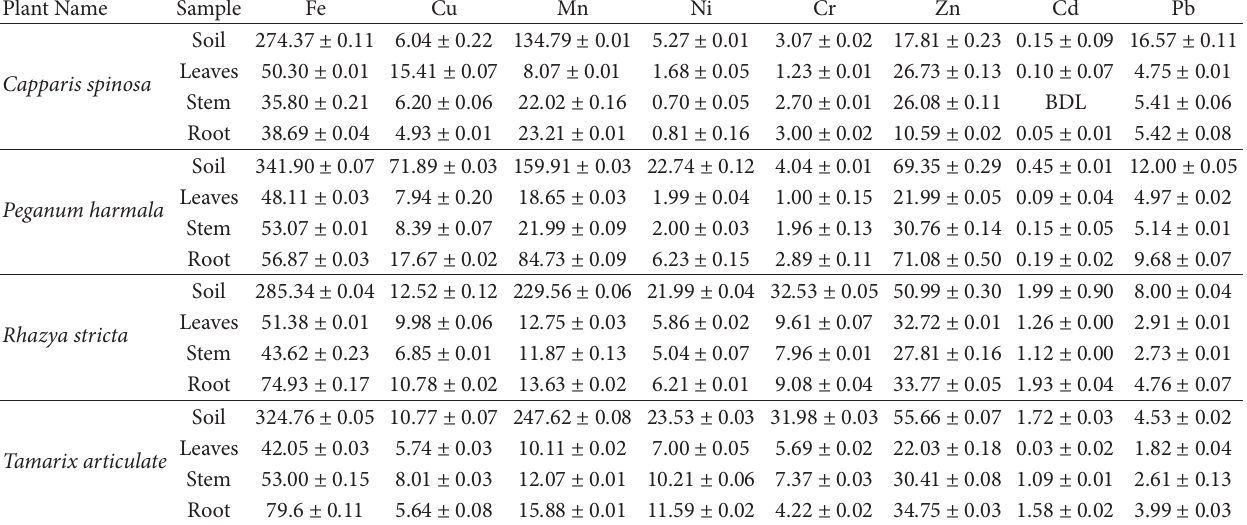
Table 1: Level of heavy metals (mg/kg) in medicinal plants and soil samples of spot-1.